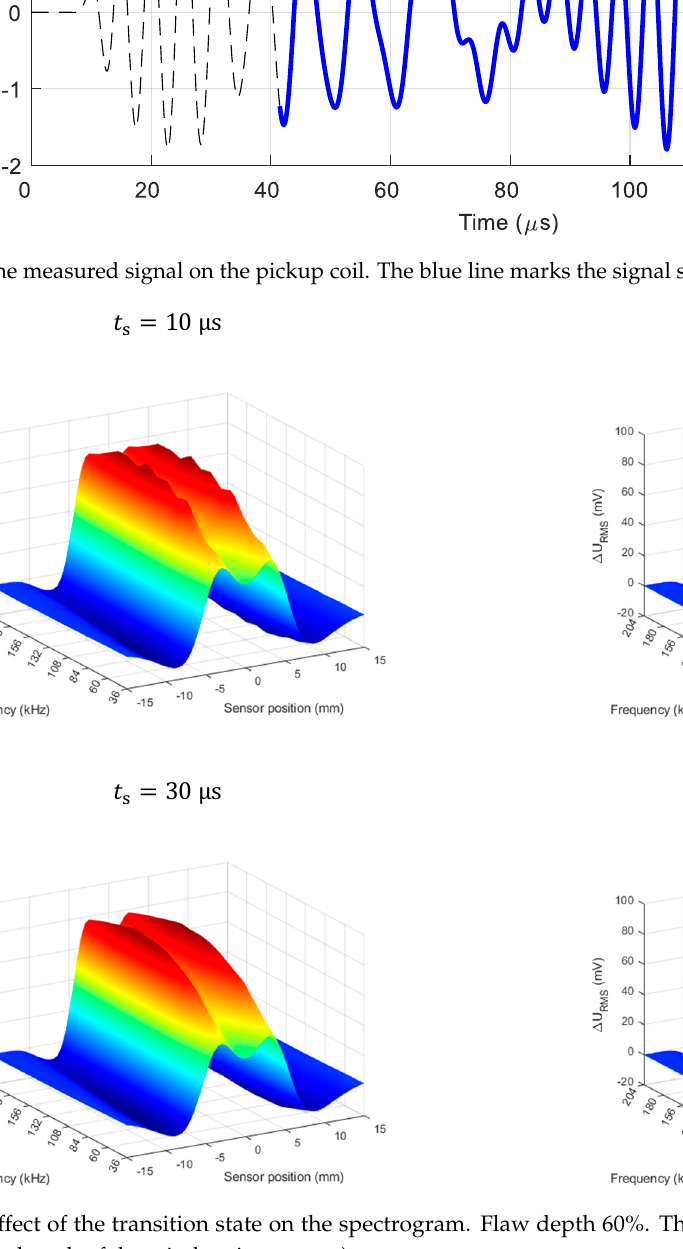
Figure 6. Effect of the transition state on the spectrogram. Flaw depth 60%. The 𝑡 𝑠 is the start time of the data analysis window (the length of the window is constant).